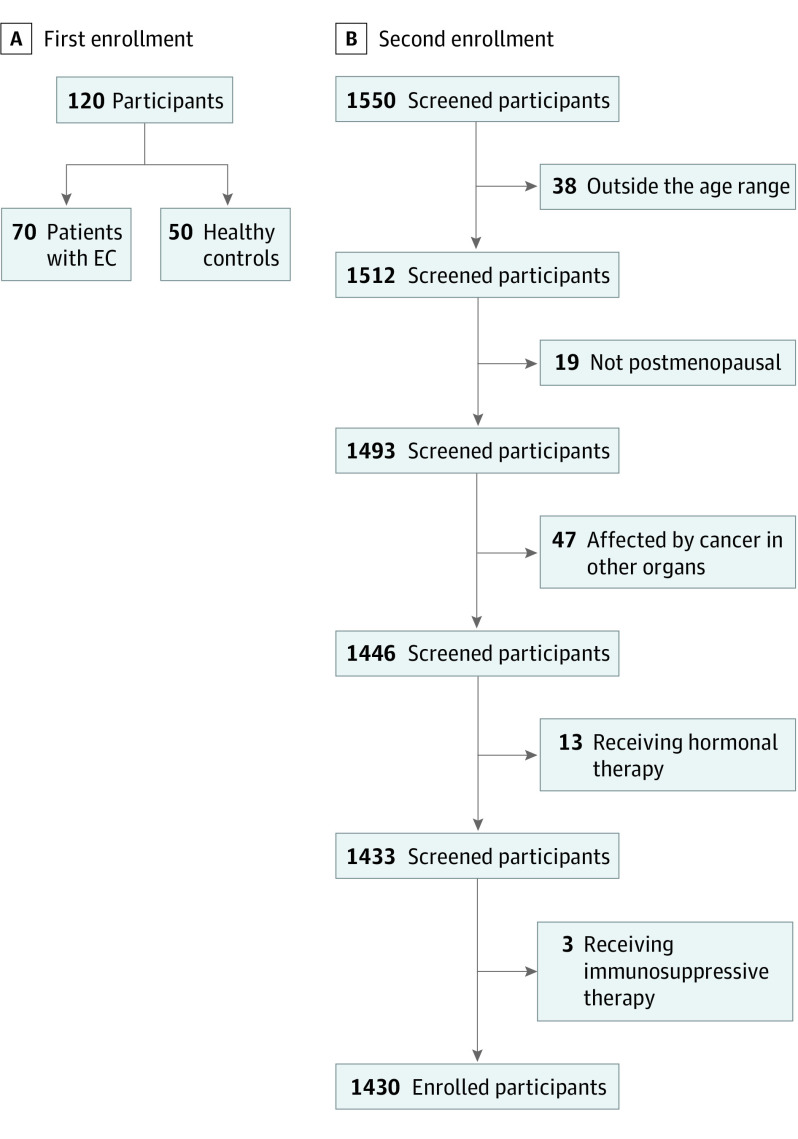
Enrollment Flow ChartThe first enrollment was the training set, and the second was the test set. EC indicates endometrial cancer.